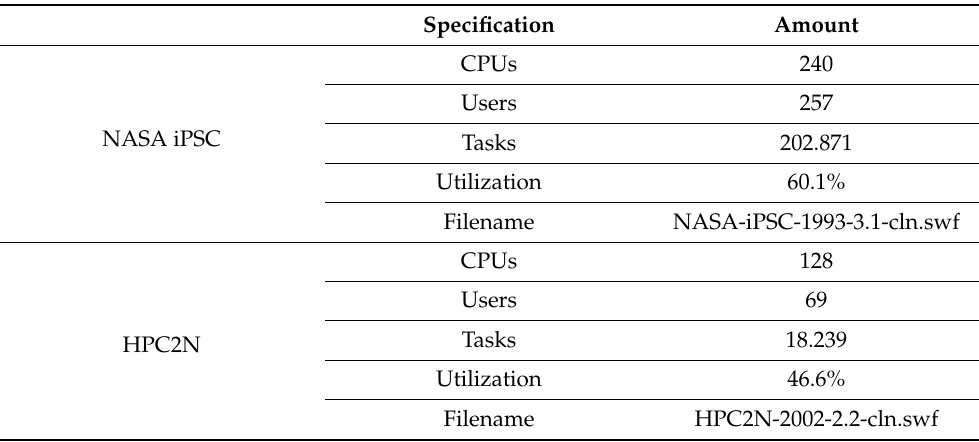
Table 2. Dataset features of HPC2N and NASA